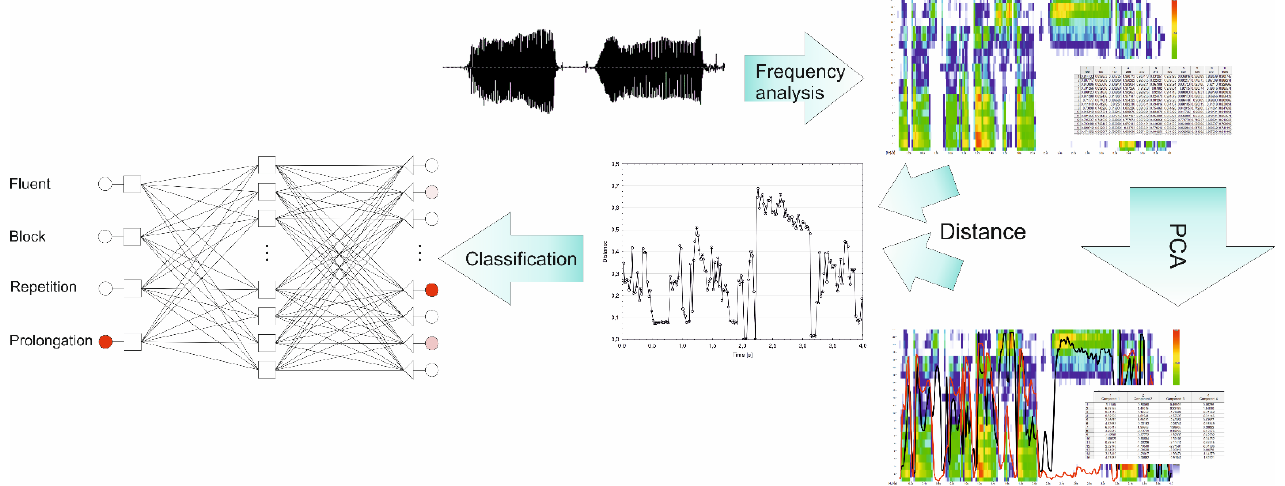
Figure 1. The experiment outline. The speech signal is transformed with FFT, 1/3 octave filters, and A-filter. Next, the PCA algorithm is applied. Based on the PCA model, the distances between new (PCA) and previous system of coordinates are calculated, and then the classification process with multilayer perceptron is conducted.